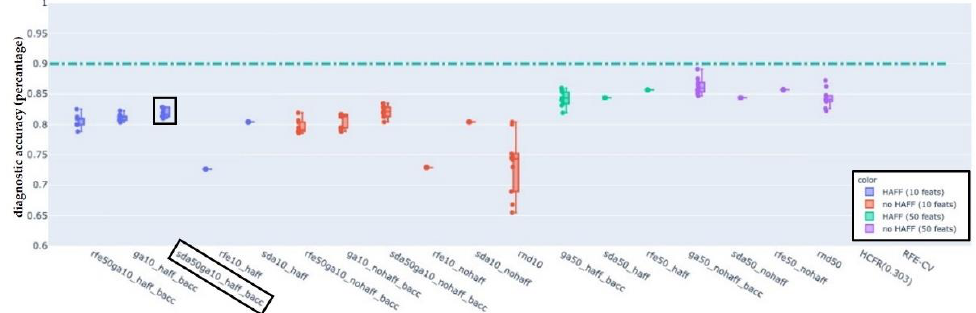
Figure 7. Balanced accuracy distributions of EFS-algorithms trained and evaluated on the LN-label “non-pathologic”. For reference, the BACC of the LDA classifier without feature count reduction (dash-dotted green horizontal line at 0.90). The combination of SDA and GA (black box) appeared to be the potentially most useful EFS-algorithms, retaining a diagnostic accuracy of >83% with only 10% of the